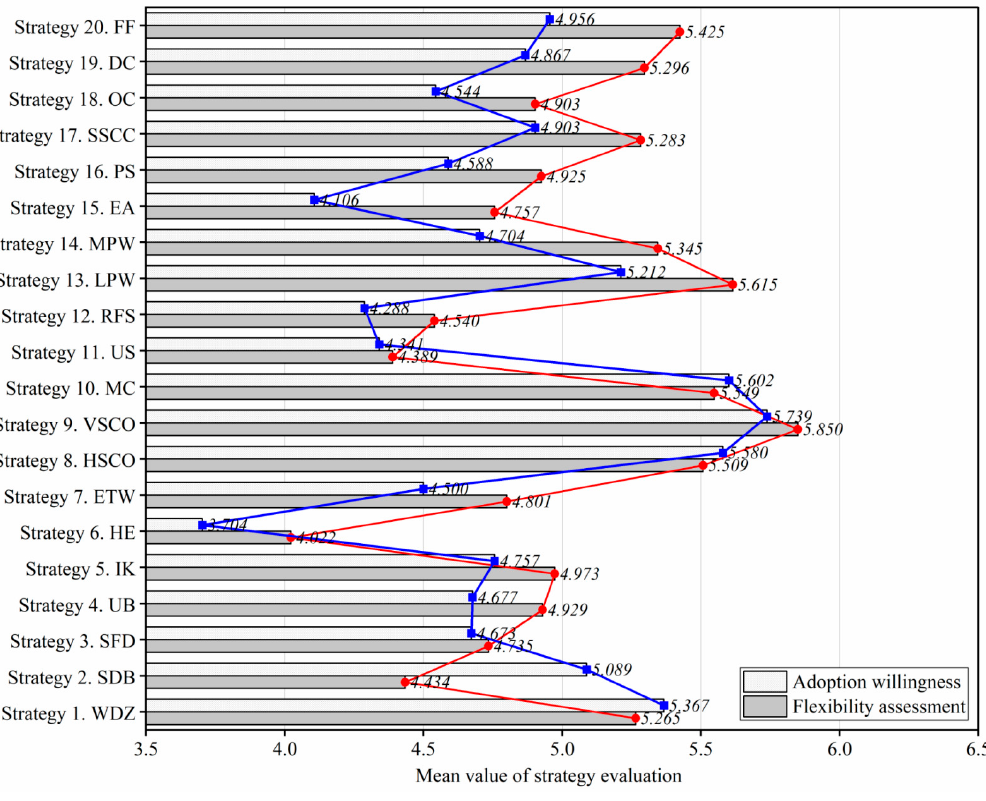
Figure 5. Mean statistics for flexibility assessment and adoption willingness.